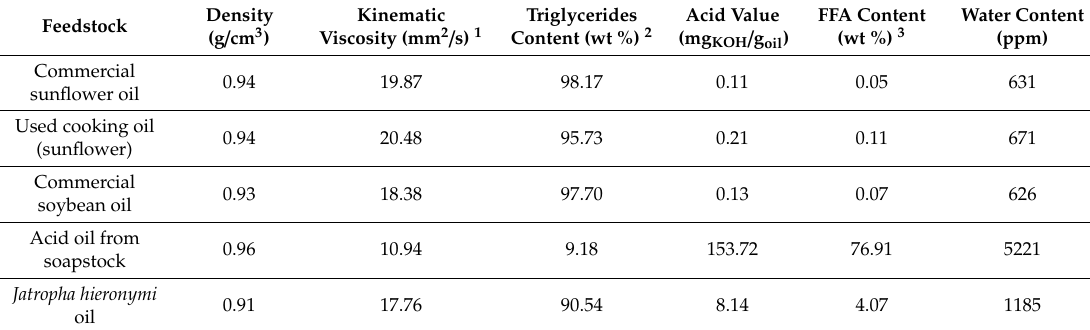
Table 1. Physicochemical characterization of the raw materials.